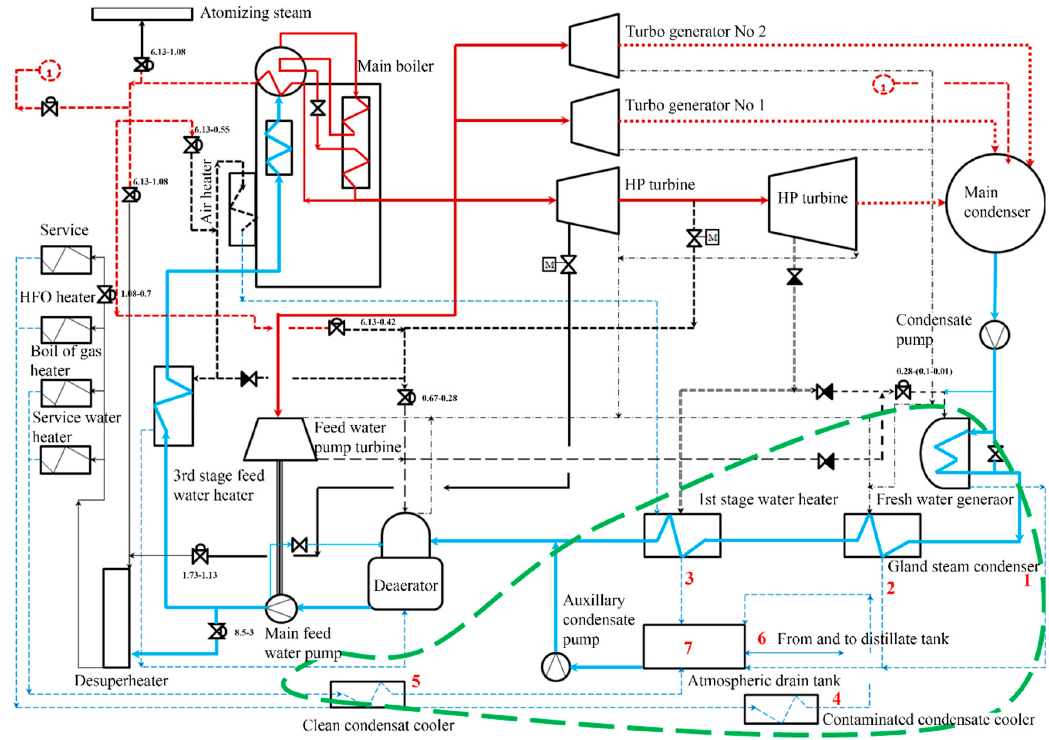
Figure 1. Marine steamship steam plant with highlighted condensate section.